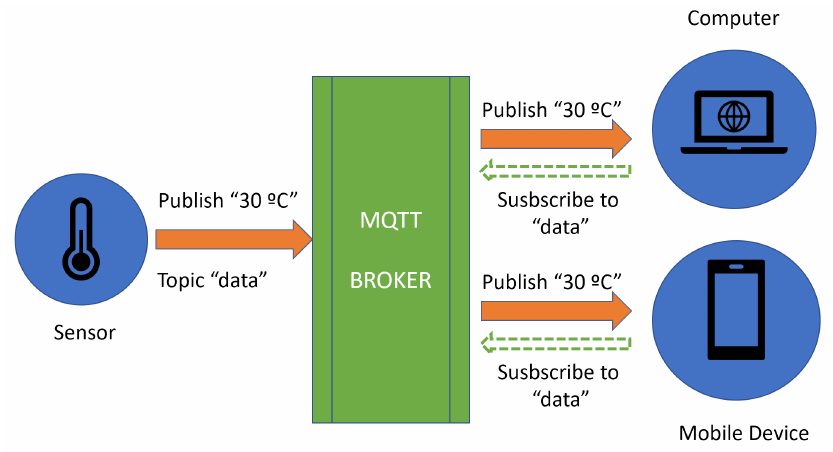
Figure 4. MQTT flow of messages for topics and